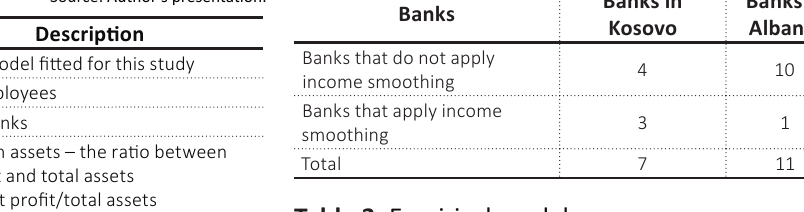
Table 3. Empirical